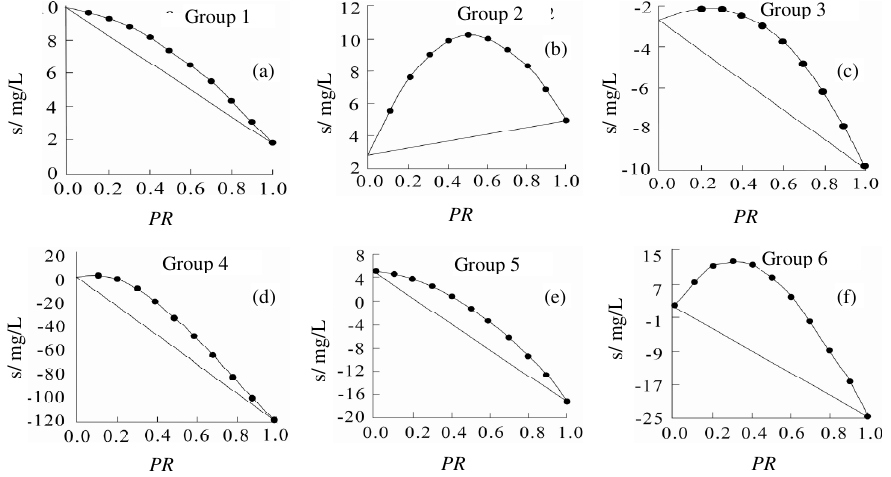
for mixed waters 3